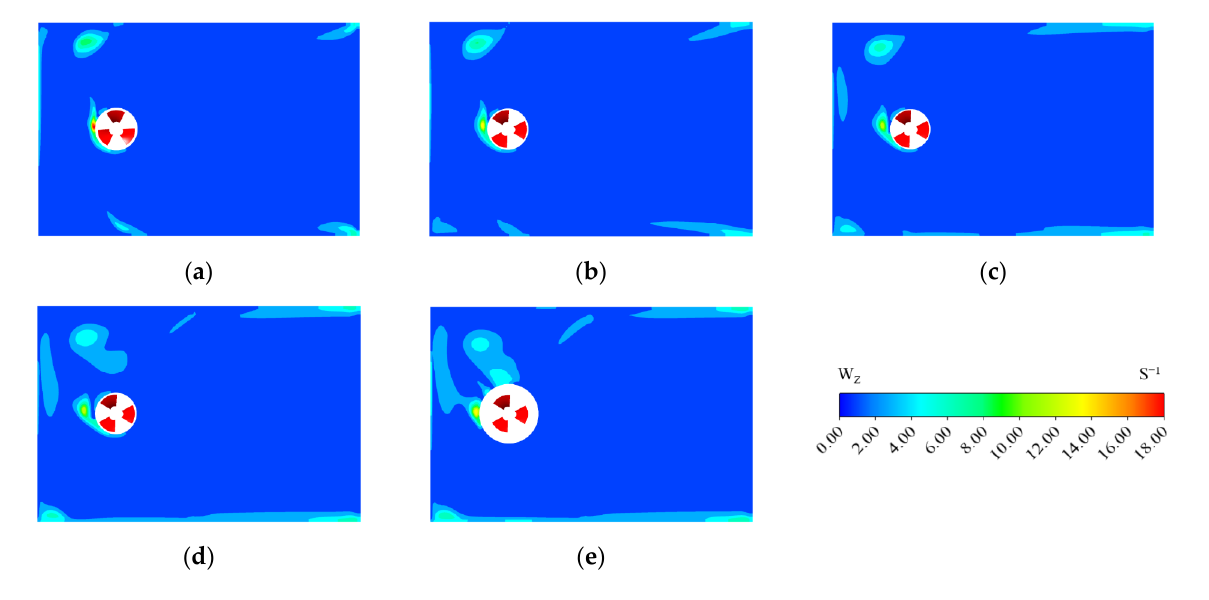
Figure 16. Vorticity intensity distribution at different sections (T). ( a ) S1. ( b ) S2. ( c ) S3. ( d ) S4. ( e ) S5.